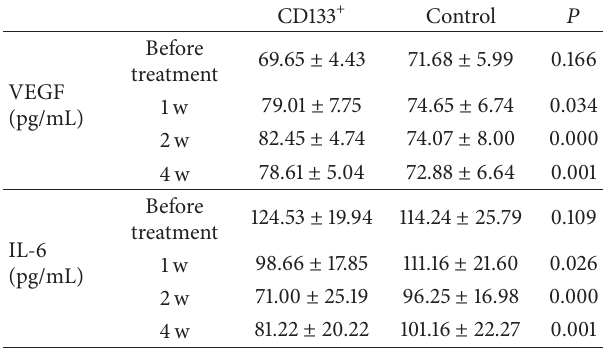
Table 4: VEGF and IL-6 level before and after